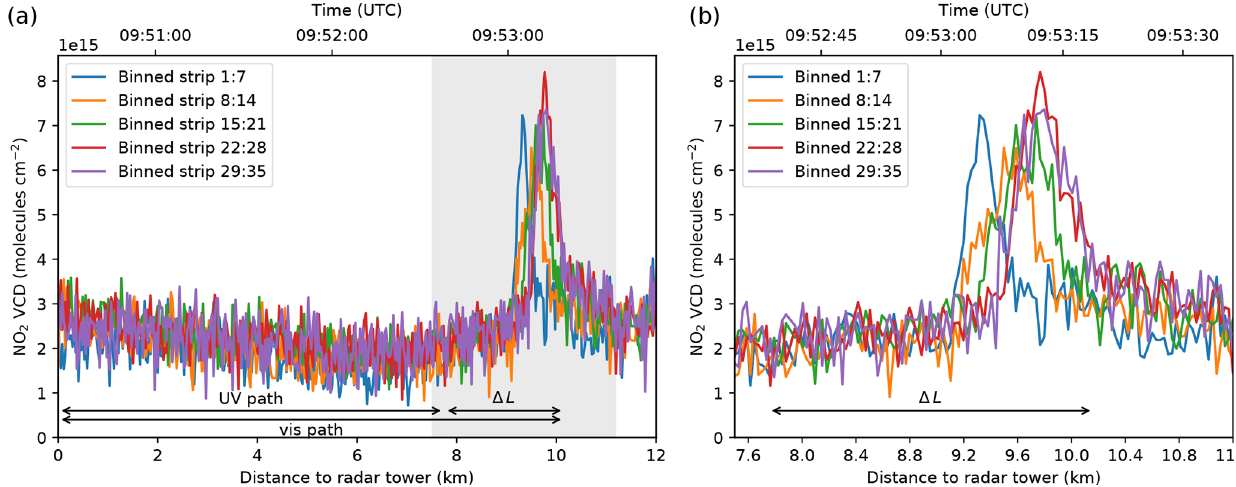
Figure 11. AirMAP vertical columns of NO 2 as a function of distance (lower axis) or time (upper axis) for the flight track section shown in Fig. 8. Panel (b) is a zoom in on the gray shaded area. Horizontal arrows denote the horizontal effective light